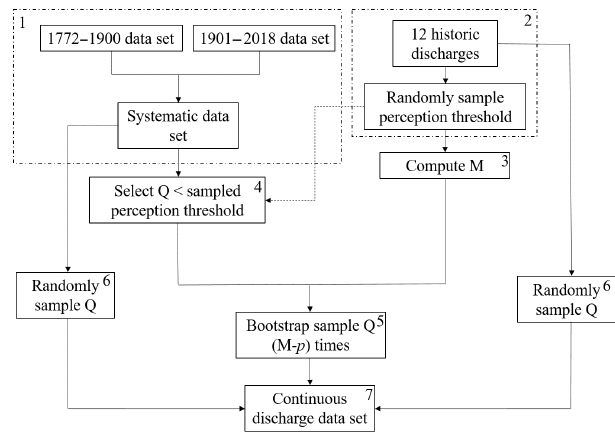
Figure 5. Bootstrap method to create a continuous discharge series in which M represents the length of the historical period and p the number of floods exceeding the perception threshold in the histori- cal